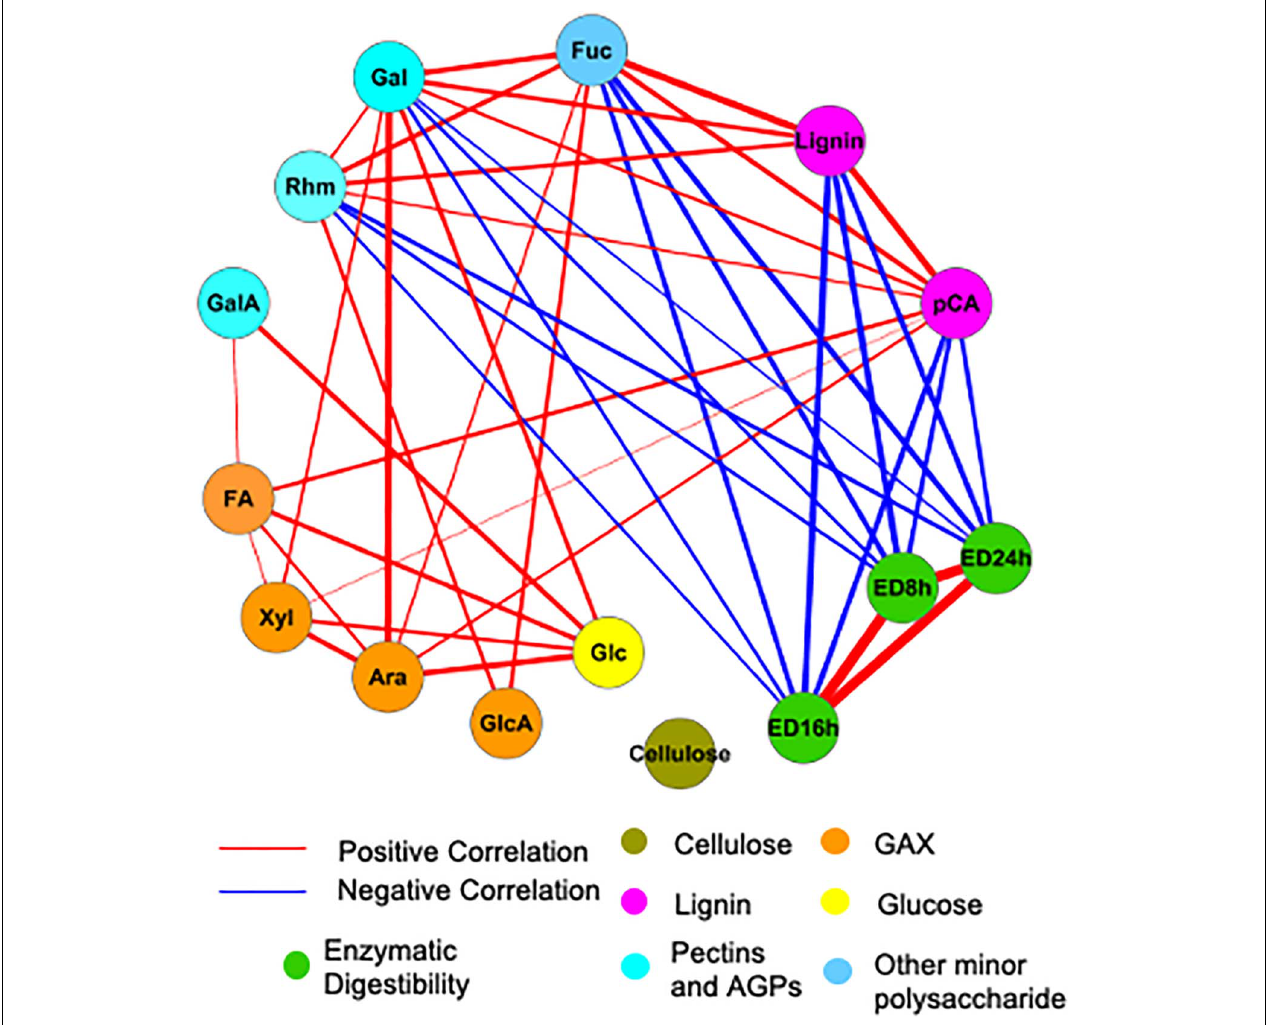
FIGURE 6 | Significant correlations among cell wall components and enzymatic digestibility (ED). Red and blue lines indicate positive and negative correlations, respectively. The thickness of lines is proportional to the absolute value of Gini correlation coefficient. Cell wall components are represented by circular nodes and color-coded based on the cell wall polymers from which they originate. Xyl, xylose; Ara, arabinose; Glc, glucose; Gal, galactose; Rhm, rhamnose; GalA, galacturonic acid; FA, ferulic acid; p CA, p -coumaric acid; ED, enzymatic digestibility. The glucose is non-crystalline cellulose, trifluoroacetic acid (TFA)-soluble glucose. GAX is glucuronoarabinoxylan. Only correlations with a q < 0.01 are shown. Correlation coefficients calculated with Gini, Pearson, and Spearman methods and corresponding P and q -values are provided in Supplementary Table 2